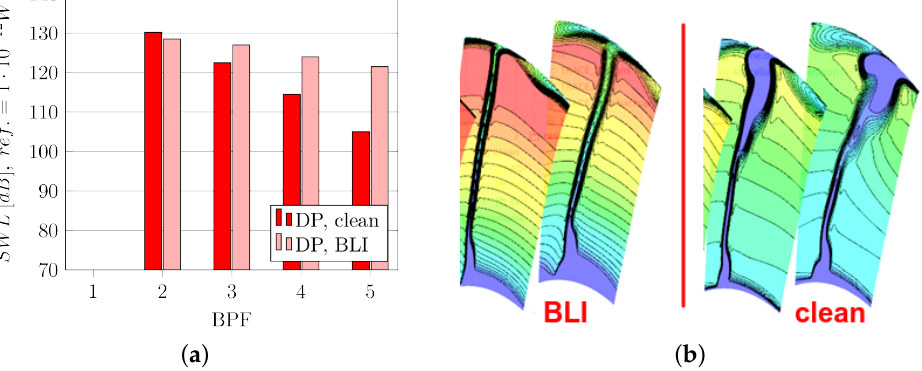
Figure 9. Results for generated tonal RSI noise and investigation of rotor wakes. ( a ) Sound power level (SWL) of tonal RSI noise with and w/o inflow distortion. ( b ) Investigation of rotor wakes close to the mixing plane with and w/o inflow distortion. Contour plots show the mean